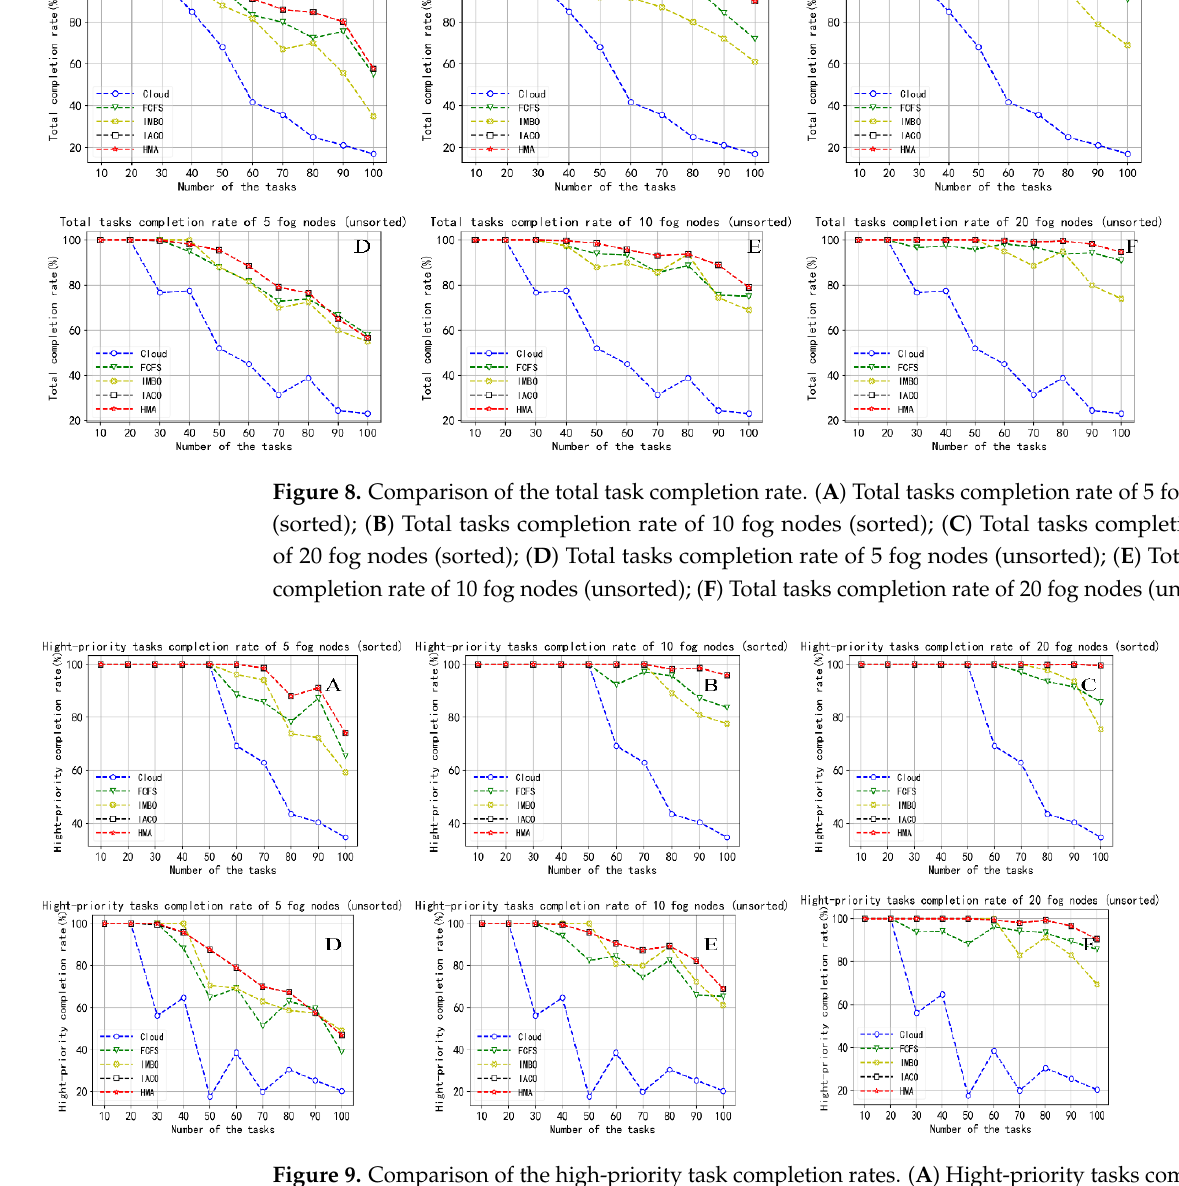
Figure 9. Comparison of the high-priority task completion rates. ( A ) Hight-priority tasks completion rate of 5 fog nodes (sorted); ( B ) Hight-priority tasks completion rate of 10 fog nodes (sorted); ( C ) Hight-priority tasks completion rate of 20 fog nodes (sorted); ( D ) Hight-priority tasks completion rate of 5 fog nodes (unsorted); ( E ) Hight-priority tasks completion rate of 10 fog nodes (unsorted); ( F ) Hight-priority tasks completion rate of 20 fog nodes (unsorted).